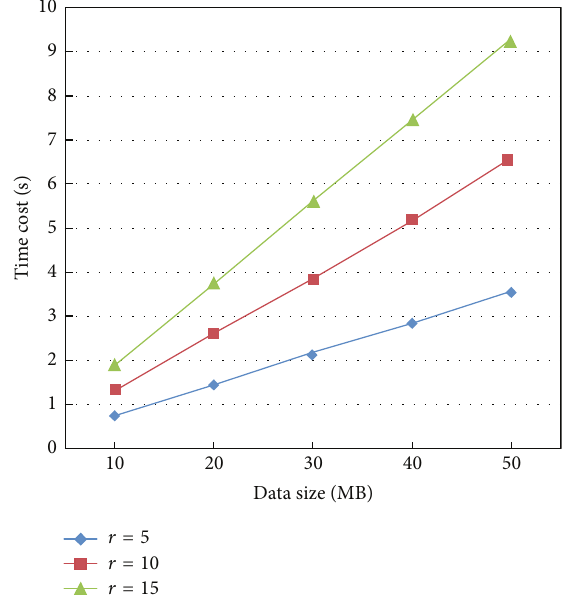
Figure 10: Time cost of EPPA under different rotation round while 5 × 5 × 5 scramble cube is chosen.